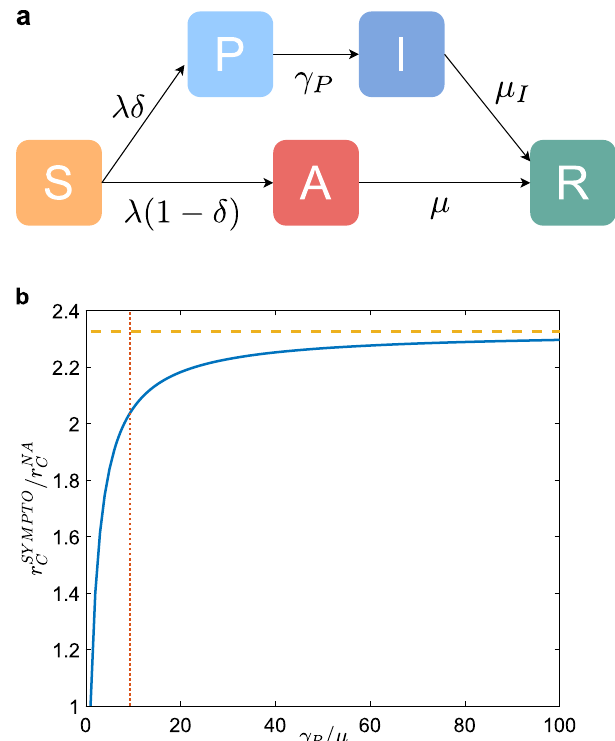
Fig. 1 Epidemic model without contact tracing. a Diagram of the compartmental epidemic model without CT. b We plot, as a function of γ μ , the ratio between the epidemic threshold r SYMPTO P / nodes are isolated and the epidemic threshold of the non-adaptive case r NA The horizontal dashed orange line indicates the value of r SYMPTO γ = ∞ (instantaneous onset of symptoms). The vertical red dash-dotted P line indicates the value of γ P / μ we consider in the rest of the paper. We set ρ ( a b = ρ a δ ( b − a S , S ) S ( S ) S S ). The curve does not depend on the speci form of ρ S ( a S